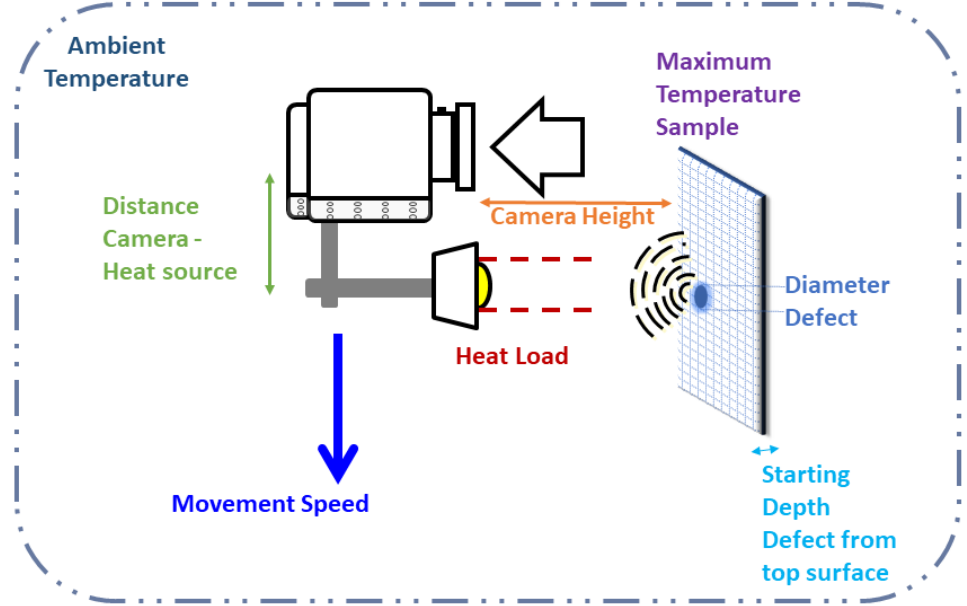
Figure 1. Visualisation of a Dynamic Line Scan Thermography set-up with the most important parameters to be optimised. The parameters in the representation are the input parameters of the response surface, except the maximum temperature is a